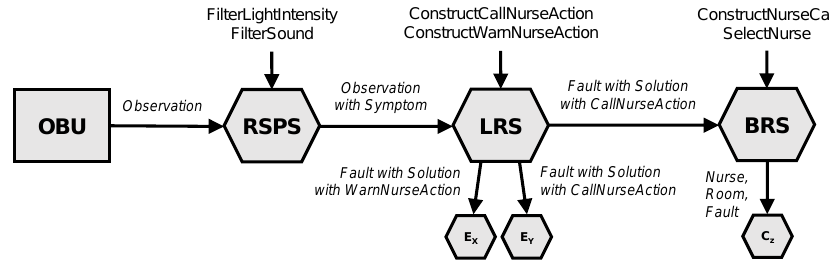
Figure 5. Overview of the components of the Proof-of-Concept. The inputs and outputs of each main component are shown in italic, as well as the queries executed on each RSP Service (RSPS), Local Reasoning Service (LRS) and Back-end Reasoning Service (BRS). The additional components E X and E Y represent the components taking local action. C Z represents the component taking care of the actual nurse call. Feedback loops are omitted from the